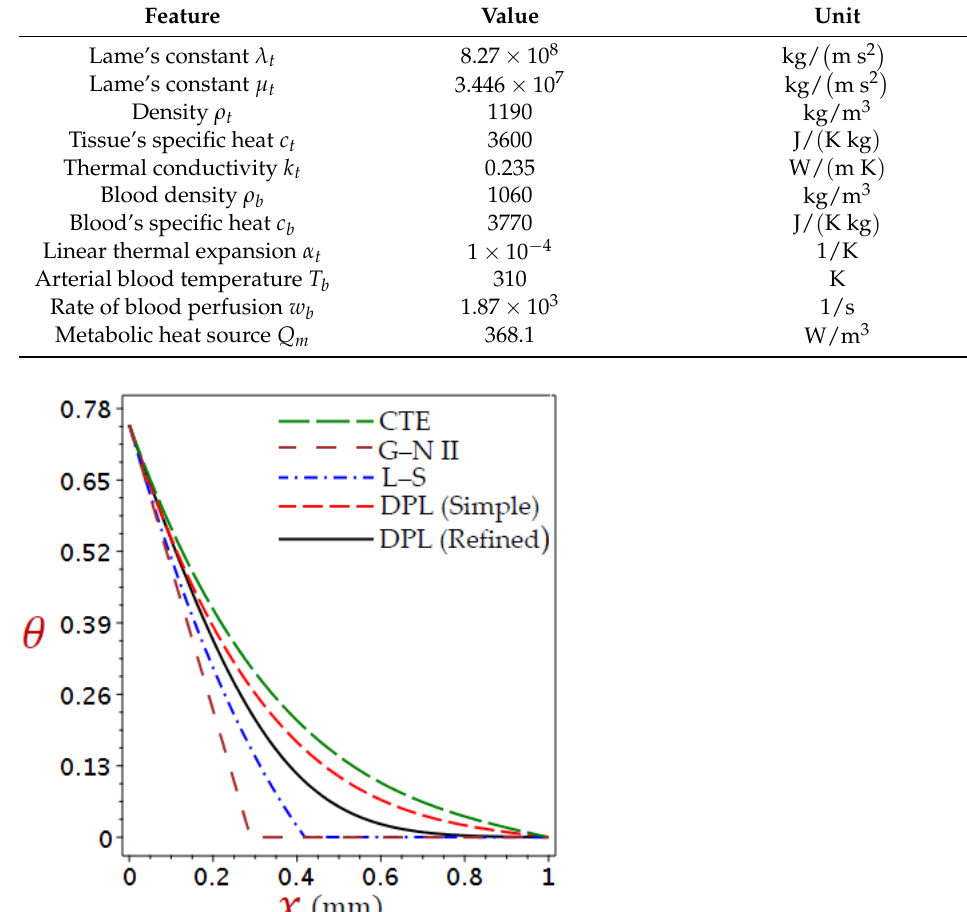
Table 1. Thermophysical features of blood and biological tissue.